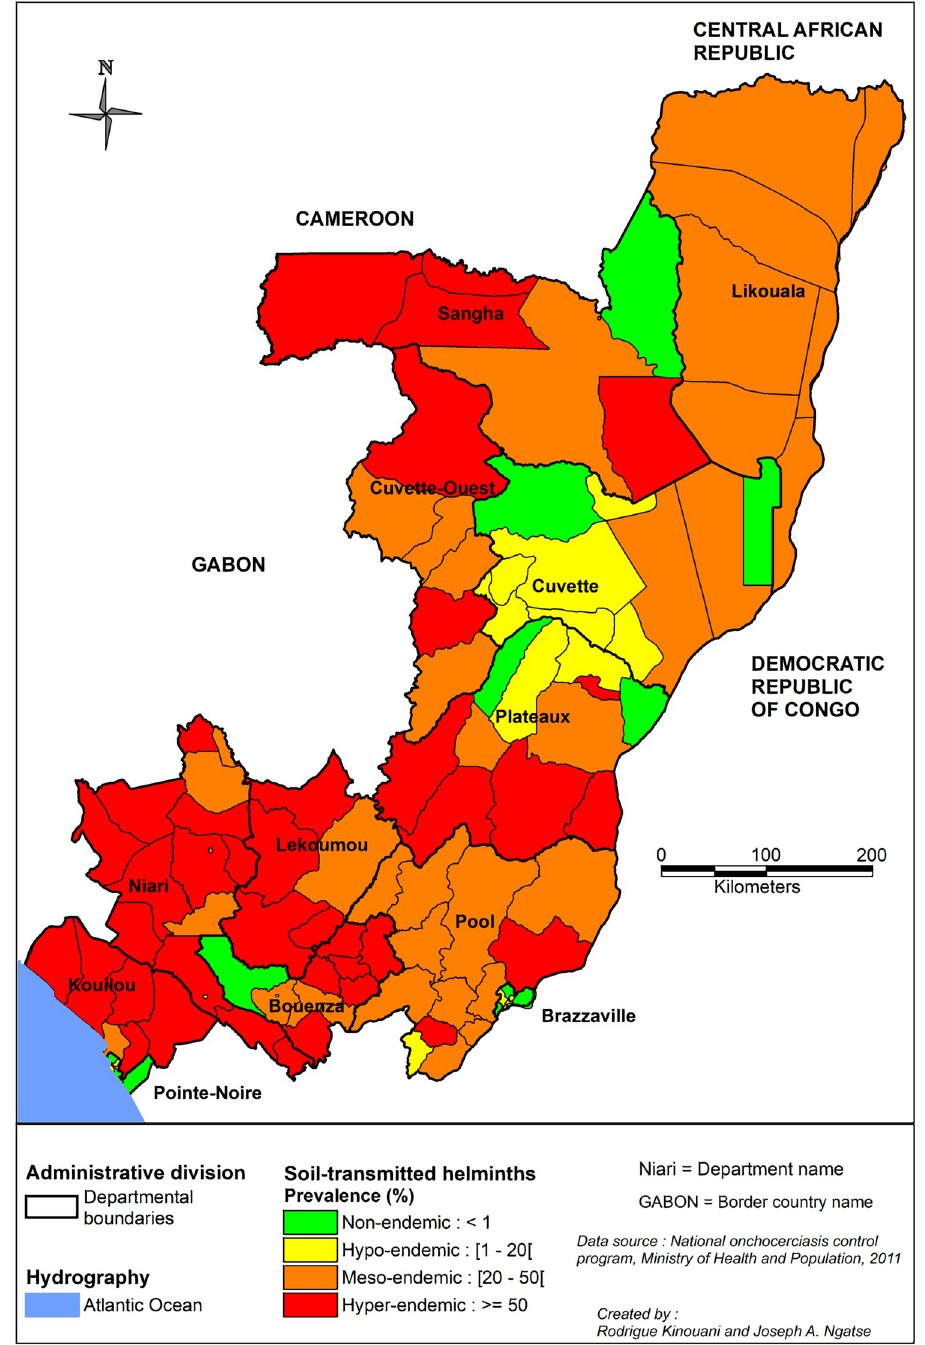
Fig 7. Distribution of soil-transmitted helminths infections in the Republic of the Congo. Data were obtained from the 2011 national survey performed by the PNLO, which used the Kato-Katz method for diagnosis. Reported prevalence values are for at least one STH. The map was created with MapInfo 8.5 (Geographic Information System, http://www.precisely.com). The base layer used of the map was created by the « Laboratoire Population Environnement De´veloppement » (LPD, UMR 151 AMU-IRD) (https://www.lped.fr/-observatoires-societe- environnement-.html) under the supervision of the Ministry of Health and Welfare of the Republic of Congo.